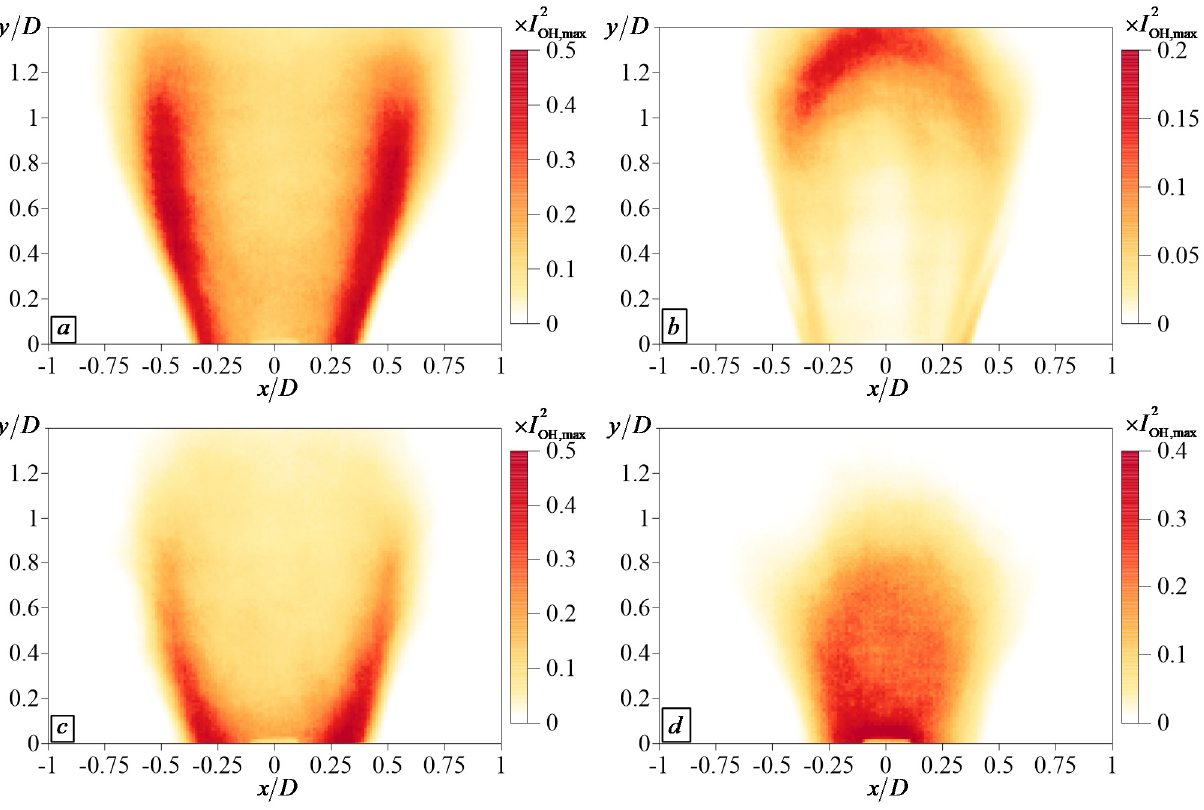
Figure 13. Local variance of OH* chemiluminescence intensity for methane ( a , c ) and syngas ( b , d ) flames at normal conditions ( a , b ) and elevated pressure and temperature ( c , d ).